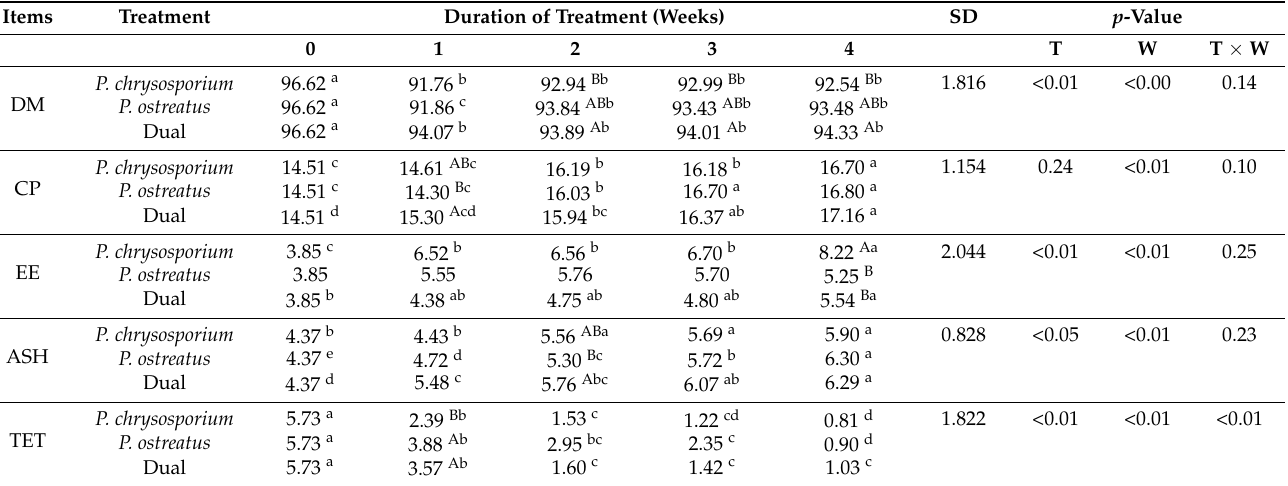
Table 1. Proximate composition (%/DM) of white tea residue after 0, 1, 2, 3, and 4 weeks of fermentation with different fungi